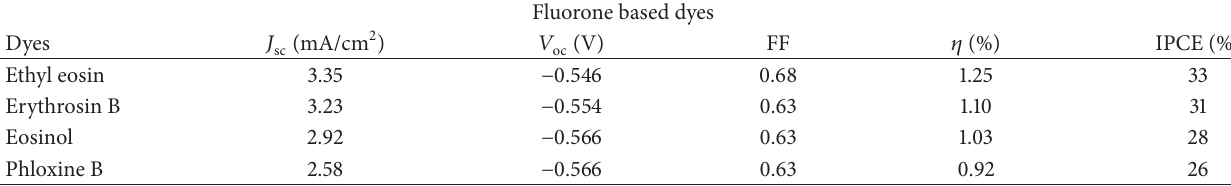
Table 2: DSSC performance parameters of fluorone based dyes.